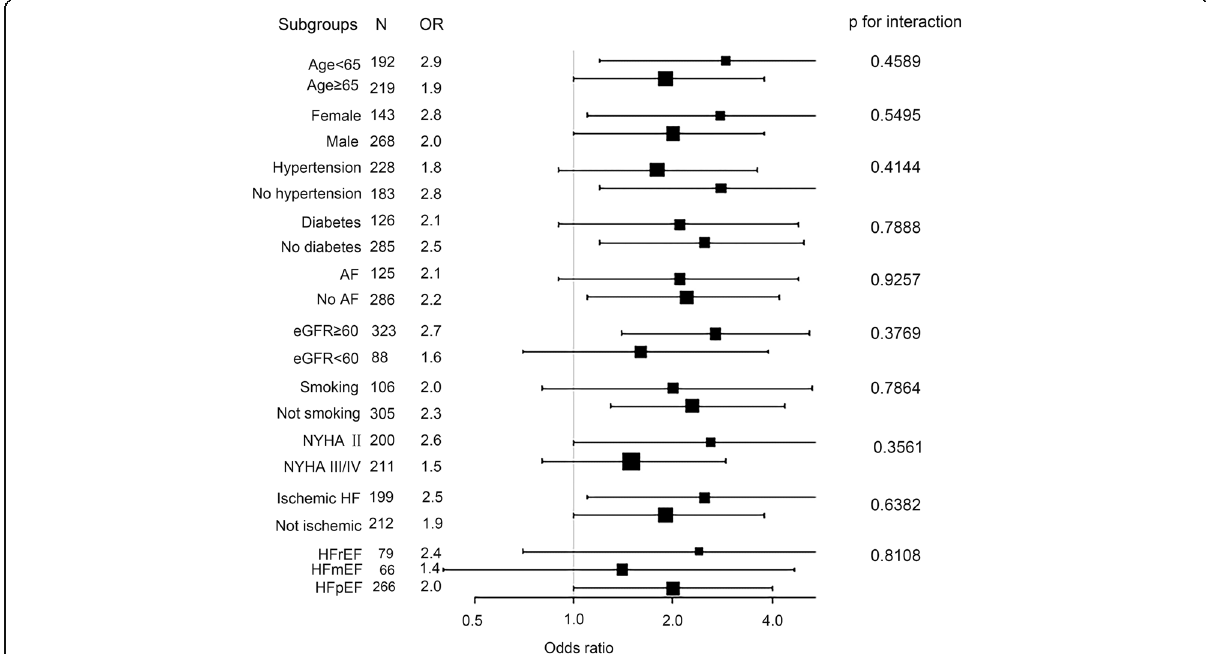
Fig. 3 Subgroup analysis of the relationship between the high 2OG group and short-term outcomes. The high 2OG group was associated with adverse short-term outcomes in other clinical subgroups. 2OG: 2-oxoglutarate, NYHA: New York Heart Association, AF: Atrial fibrillation, eGFR: estimated glomerular filtration rate, HFrEF: HF with reduced ejection fraction, HFmEF: HF with mid-range ejection fraction, HFpEF: HF with preserved ejection